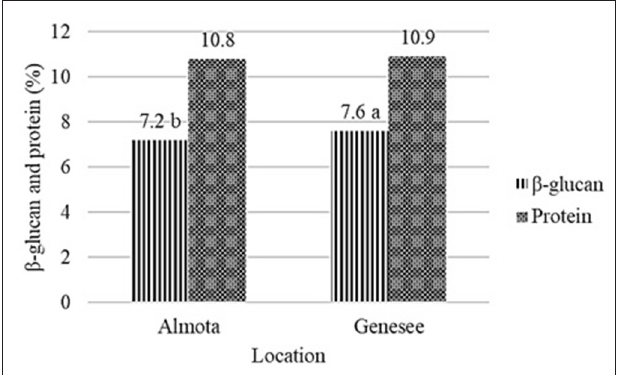
FIGURE 2 | Effect of location on β -glucan and protein content of barley across all varieties and years. Dissimilar letters in a column are significantly different at p ≤ 0.05.